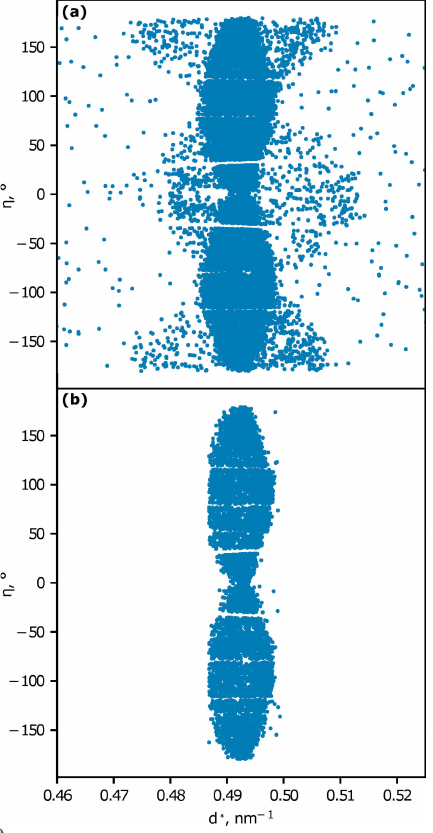
Figure 10 Radially integrated {110} plot of peaks from one letterbox scan ( a ) before filtration and ( b ) after filtration.